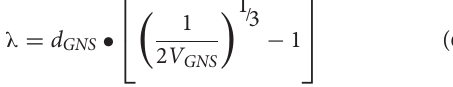
Frontiers in Bioengineering and Biotechnology |